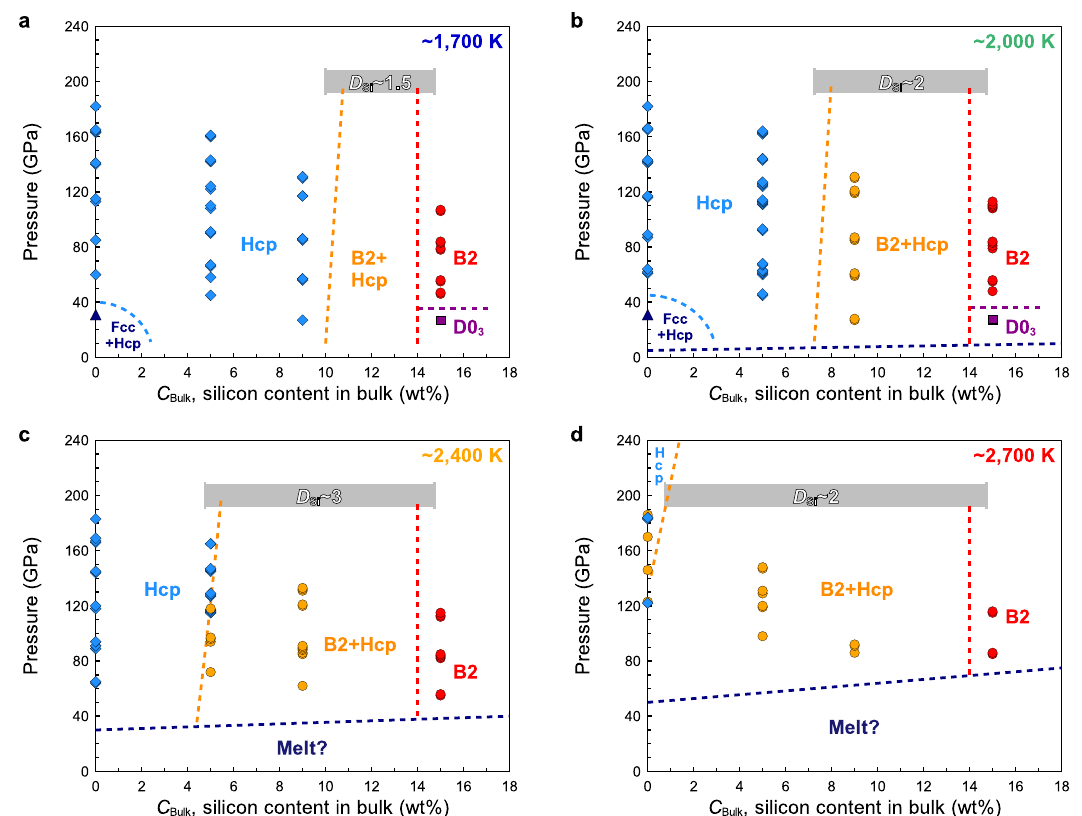
Fig. 4 Silicon content – pressure phase diagrams in the Fe – Ni – Si system at high pressure. a ~1700 K, b ~2000K, c ~2400 K, and d ~2700 K. The dashed lines indicate presumable phase transition boundaries estimated by the fraction of the two phases based on X-ray peak intensities. The pressure – temperature phase boundaries are shown in Fig. 2. The grey bars represent the typical partition coef fi cients of silicon ( D Si ) (i.e., the ratios of silicon contents of the B2 ( C B2 ) and the hcp ( C Hcp ) phases at 200 GPa. Errors are within symbols. Table 1 Parameters of the equation of state for hexagonal close-packed (hcp) and ordered derivatives of body-centred cubic (B2/D0 3 ) phases in Fe – Ni – Si